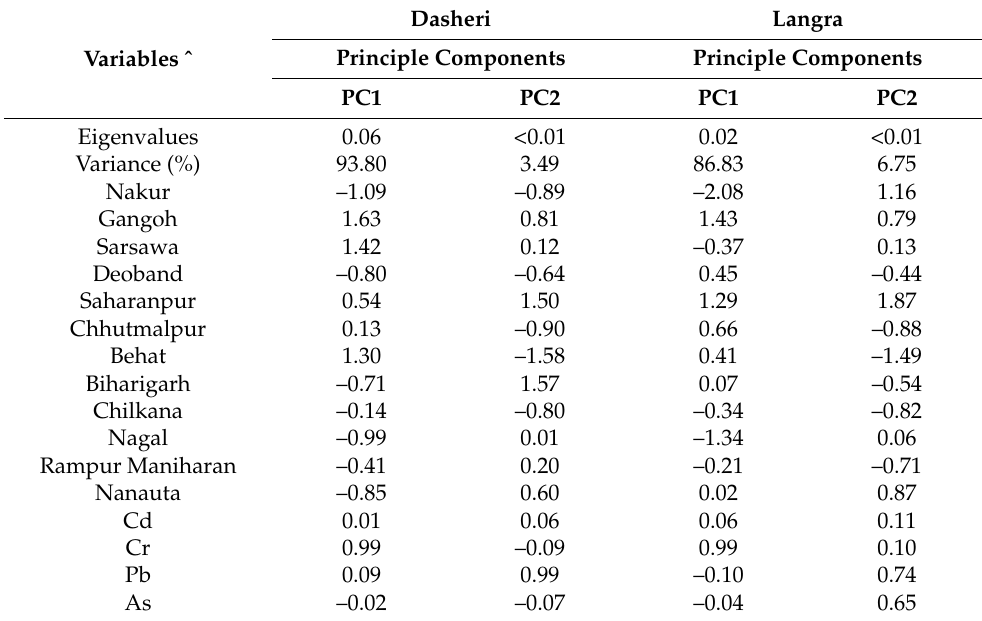
heavy metals in mango fruits and their respective sampling locations across Saharanpur ˆ: Refer to Table 1 for the location abbreviations.